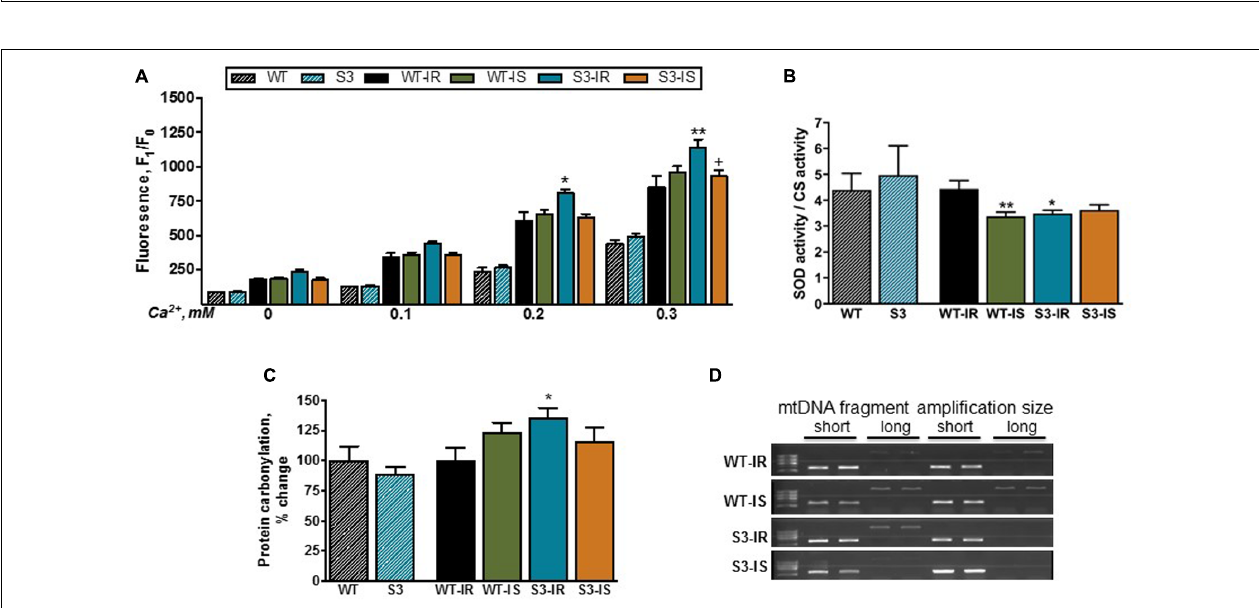
FIGURE 4 | Activity of ETC complexes I–IV (A–D) and citrate synthase (E) in cardiac mitochondria of WT and SIRT3 − / − mice. Enzymatic activity of ETC complexes was measured spectrophotometrically using a specific substrate for each complex (see Materials and Methods). The activity of complexes was normalized to citrate synthase (CS) whereas CS activity was normalized to mg of mitochondrial protein. Groups are the same shown in Figure 1 . ∗ P < 0.05, ∗∗ P < 0.01 vs. WT-IR. n = 5–7 per group.